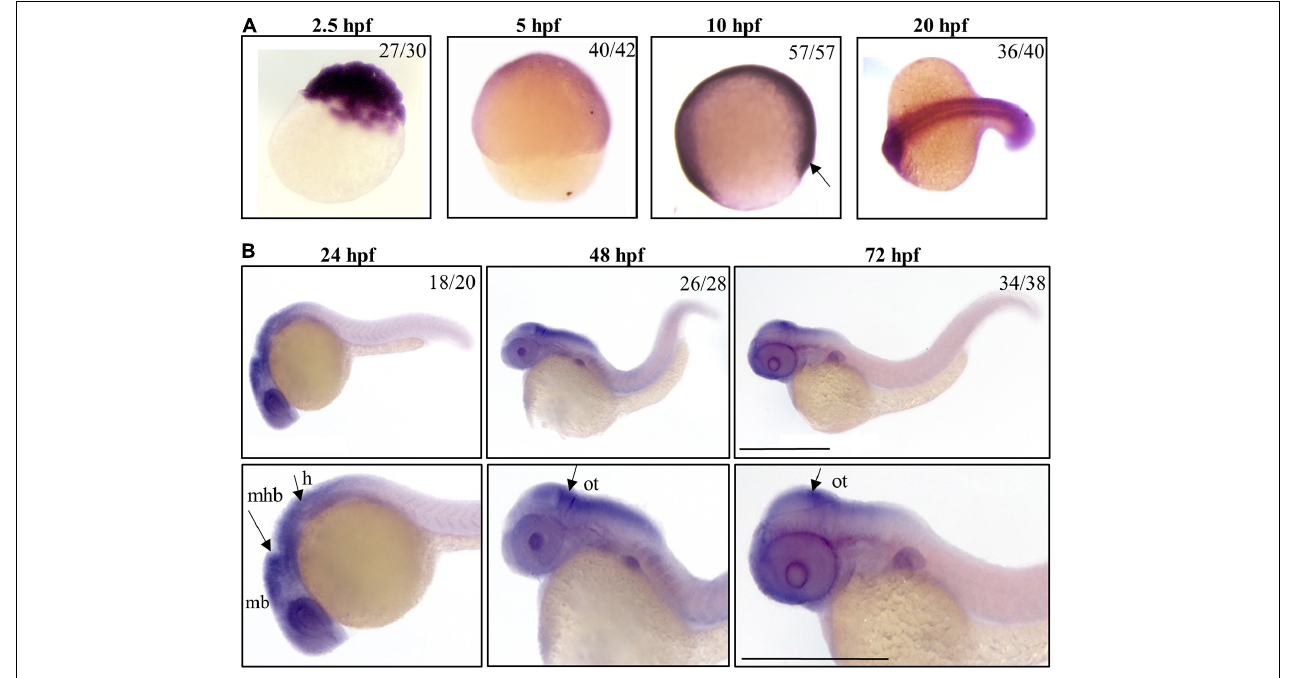
FIGURE 1 | Spatio-temporal analysis of gene a expression in zebrafish embryos. Representative images of embryos at early (A) or later (B) stages of development, hybridized with a probe specific for c19orf12a mRNA. Numbers in each panel represent embryos used for the experiment and embryos with the result shown in the image. Each hybridization was performed at least twice. Scale bars = 500 µ m. mb, midbrain; mhb, midbrain-hindbrain boundary; h, hindbrain; ot, optic tectum.